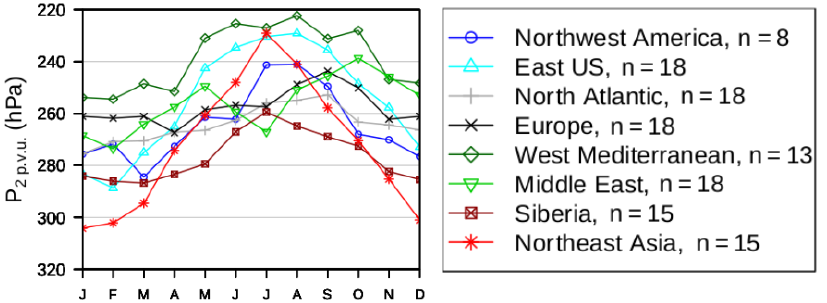
Figure 5. Mean seasonal cycles of P 2pvu (hPa) in each region. The average has been calculated by selecting the same years as for the O 3 mixing ratio; this amount is indicated in the legend as the number n